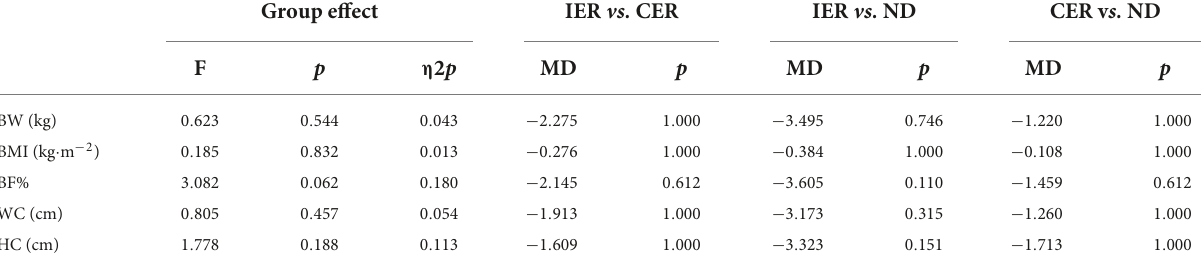
TABLE 5 Comparison of body composition and anthropometric parameters between groups.